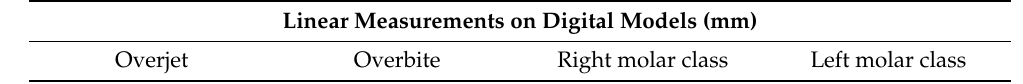
Table 3. Linear values measured on digital models.